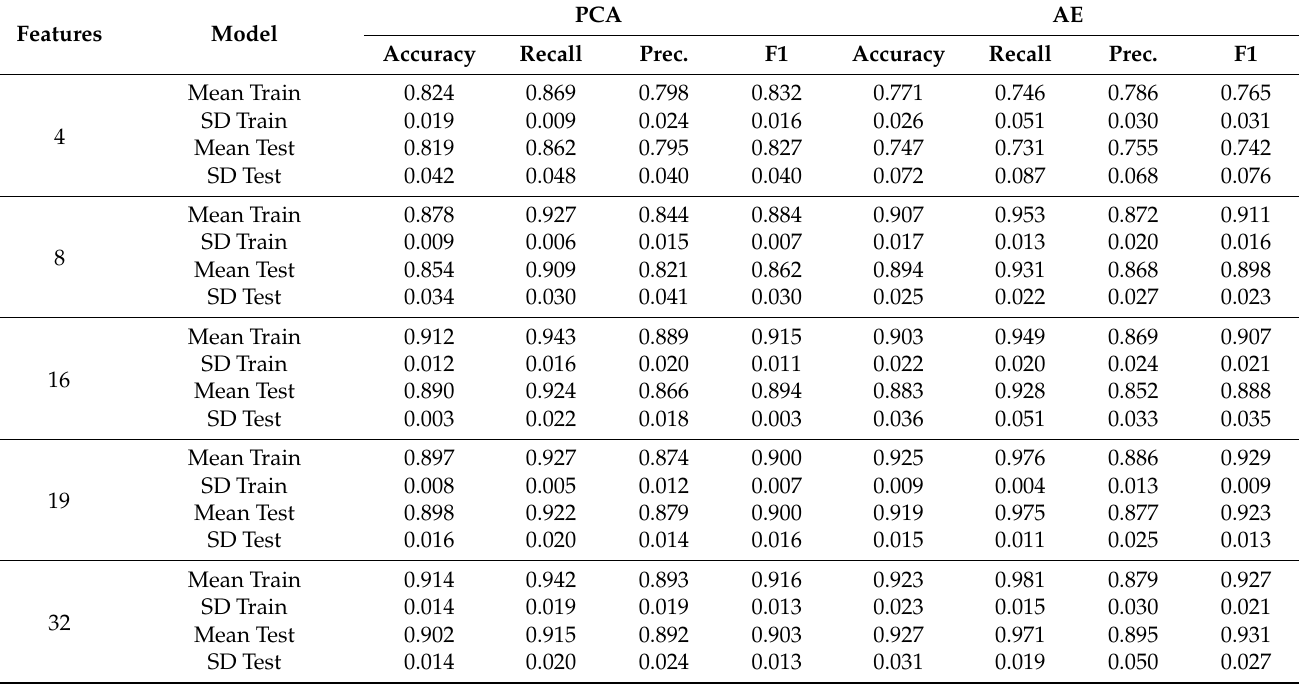
Table A3. Binary classification metrics for SVM-linear kernel per number of PCs and AE latent space